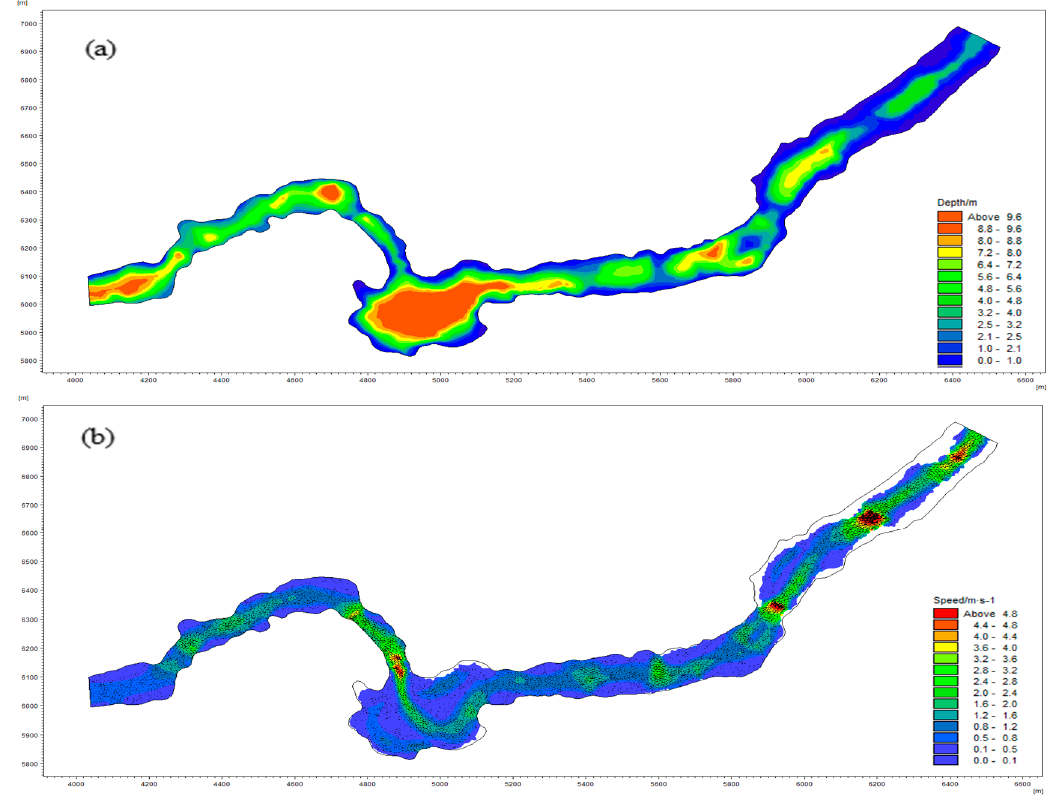
Figure 9. Distribution of river depth ( a ) and flow velocity ( b ).